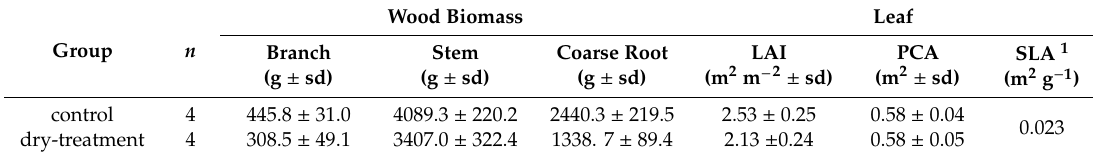
Table 2. Biomasses of branch, stem and coarse roots of both the control and the dry-treatment groups from the harvesting campaign as well as leaf area index (LAI) and projected canopy area (PCA) measured in summer